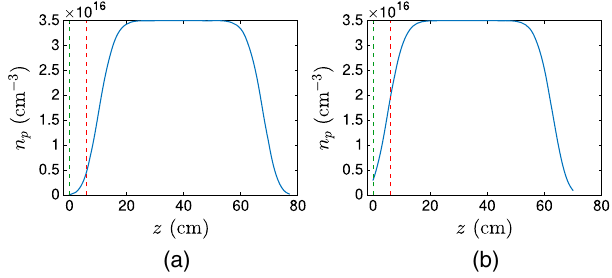
FIG. 3. Plasma density profile. The green dashed line is the entrance of the plasma, and the red dashed line is the position of the witness beam ’ s focal plane in vacuum. The beams propagate to the right in the plot. (a) The FACET II plasma density profile. (b) The profile used for the simulation results in Fig. 4. Only the region between 5 cm and 75 cm of the profile in (a) is used. In this region the adiabatic condition is always